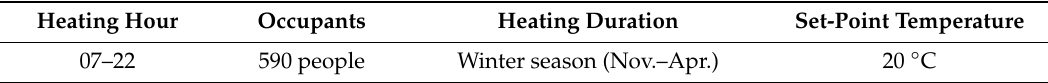
Table 6. Operation plan of the building.